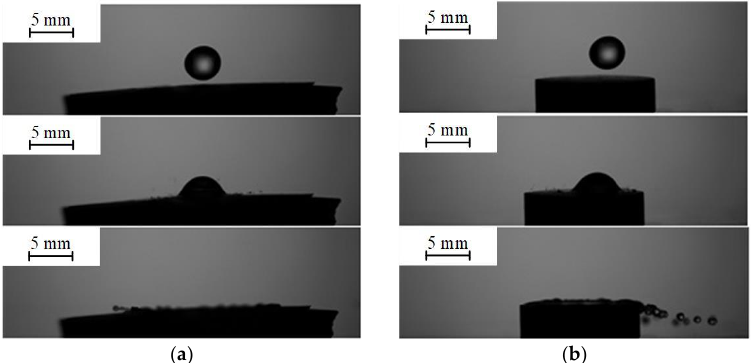
Figure 15. Images of collisions of distilled water droplets with substrates of anthracite when varying the substrate type, R d = 2 mm, U d = 2.6 m/s: ( a ) — monolithic fragment; ( b ) — pressed pellet.